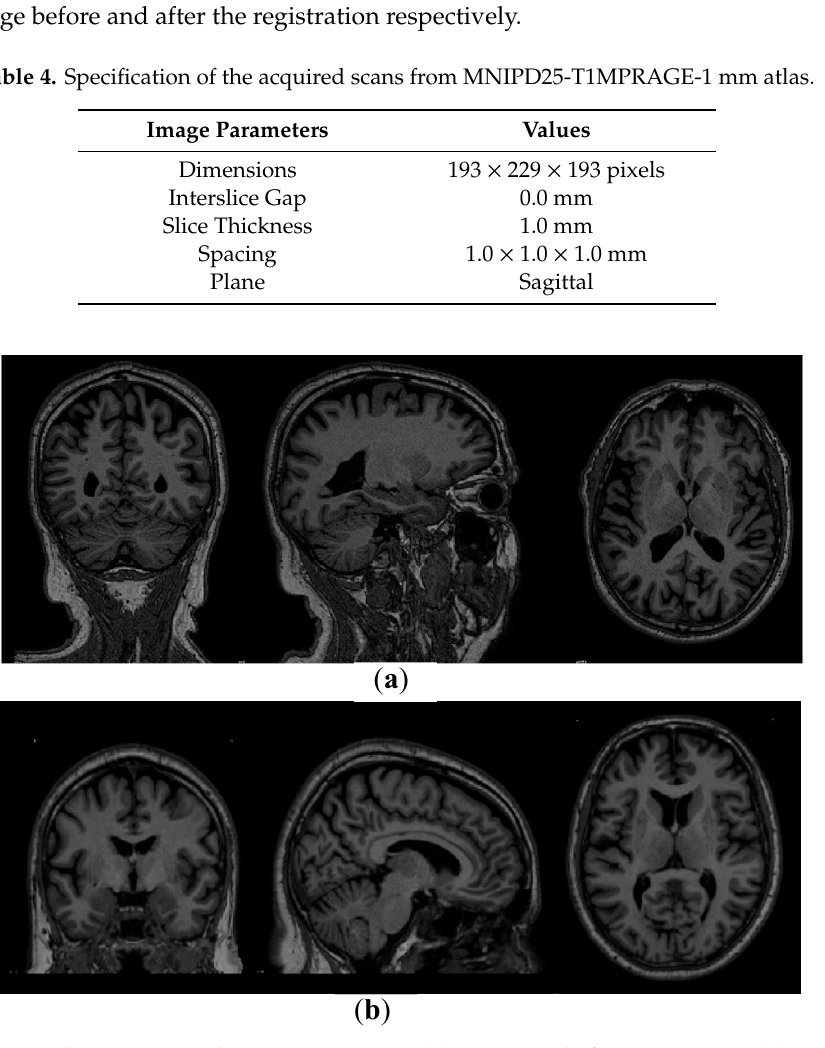
Figure 2. Sample scan pre and post-registration. ( a ) MRI scan before registration ( b ) MRI scan after registration.